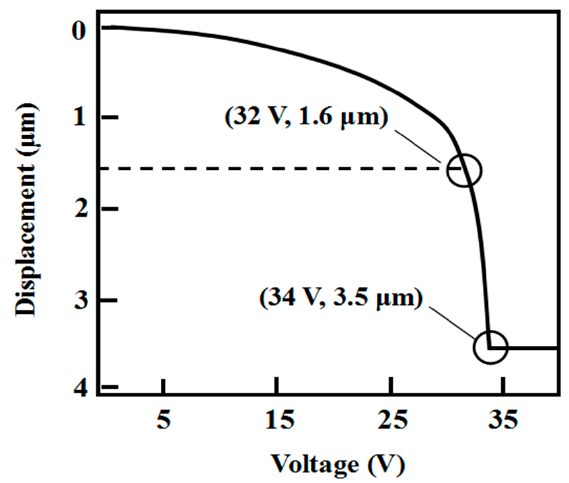
Figure 5. Relationship between displacement and voltage. Table 2. Comparison between pull-in voltage and threshold Table 2. Comparison between pull ‐ in voltage and threshold voltage.